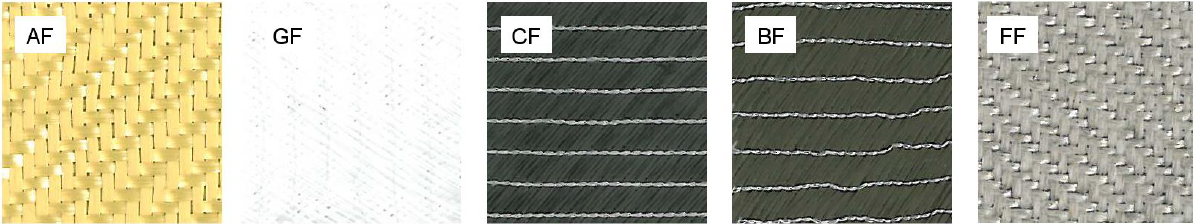
Figure 1. Photographs of fabrics used for the manufacturing of the epoxy-based laminates.